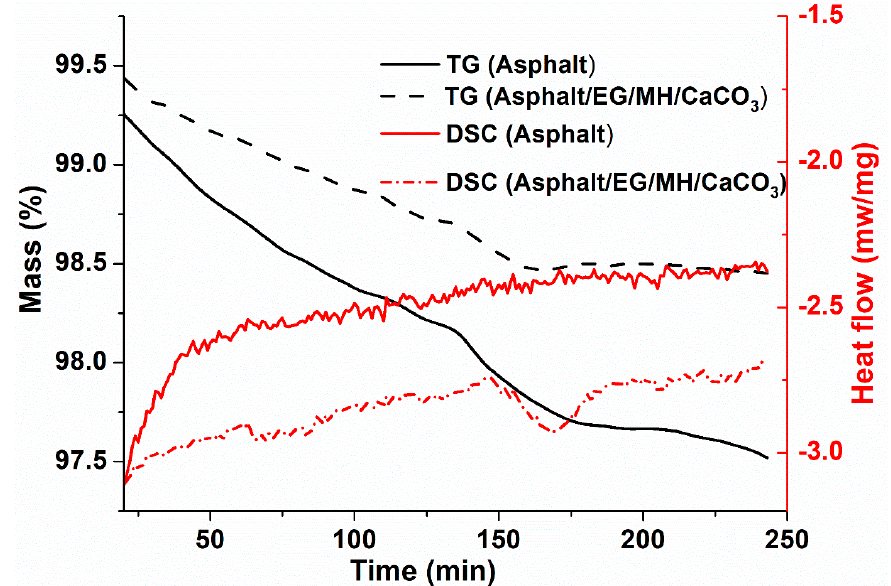
Figure 5. TG and DSC curves of asphalt and asphalt/EG/MH/CaCO 3 during the isothermal-oxidative